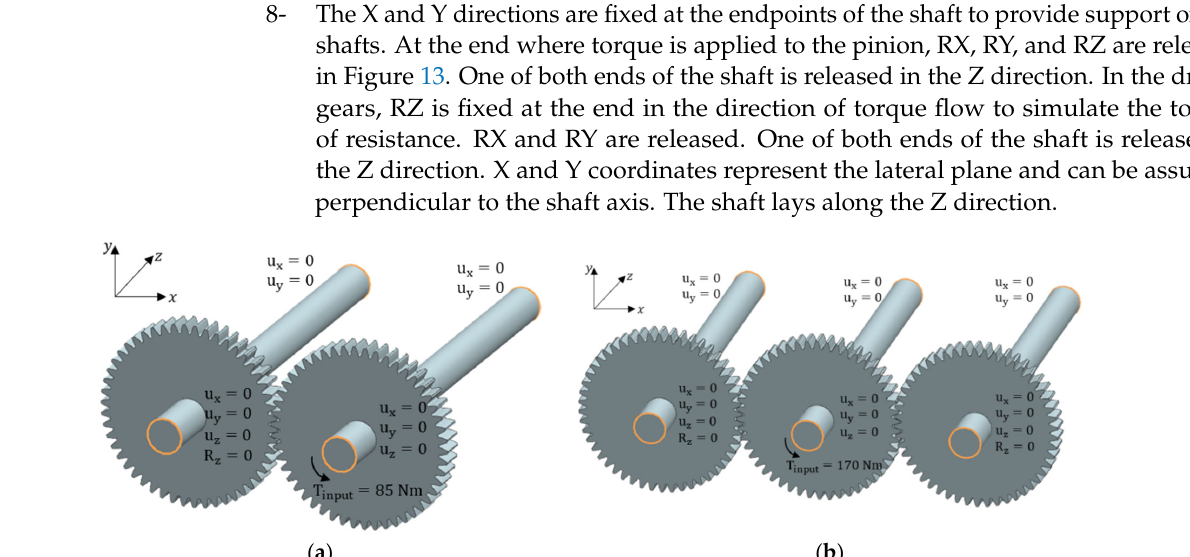
Figure 12. ( a ) Mesh structure on the gear. ( b ) Torque split model contact regions. 8 ‐ The X and Y directions are fixed at the endpoints of the shaft to provide support on the shafts. At the end where torque is applied to the pinion, RX, RY, and RZ are re ‐ Figure 13. Boundary conditions. ( a ) Gear pair. ( b ) Torque split model. Figure 13. Boundary conditions. ( a ) Gear pair. ( b ) Torque split model. torque of resistance. RX and RY are released. One of both ends of the shaft is released 9- 85 Nm torque for the gear pair and 170 Nm for the torque split are applied to the in the Z direction. X and Y coordinates represent the lateral plane and can be as ‐ pinion from one end in a certain period and the system is loaded. sumed perpendicular to the shaft axis. The shaft lays along the Z direction.